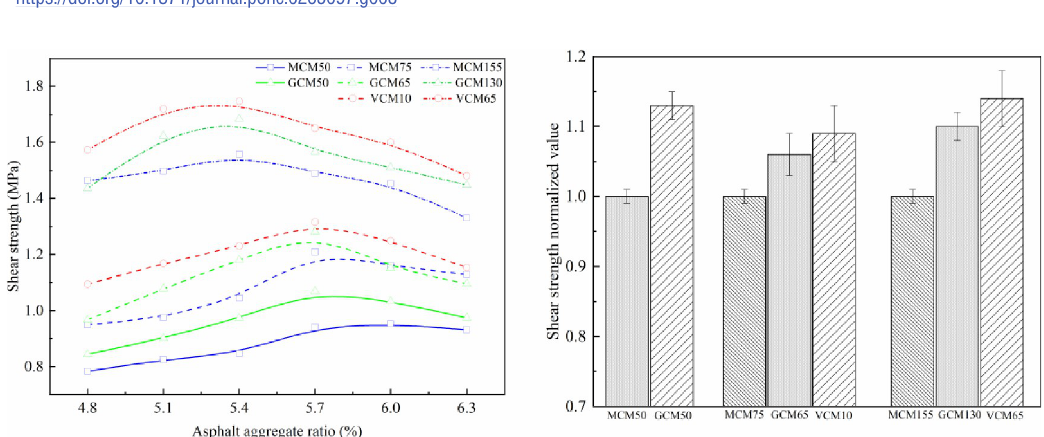
Fig 8. Effect of compaction on compressive strength under different compaction methods. (a)Compressive strength versus asphalt-aggregate ratios (b) Compressive strength normalized value.